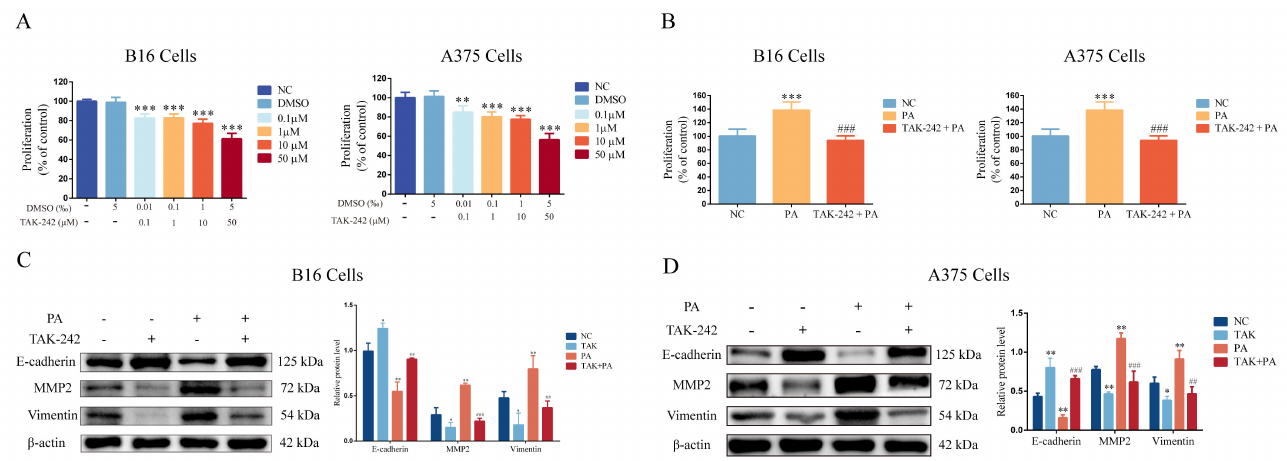
Figure 4. TAK-242 treatment inhibited the proliferation, and changed the expression, of EMT re- lated proteins induced by PA in the B16 and A375 cells. ( A ) The level of cell proliferation after B16 and A375 cells were incubated with TAK-242. ( B ) The level of cell proliferation after B16 and A375 cells were incubated with TAK-242 and/or PA for 24 h. ( C ) Protein levels and quantitative anal- ysis of E-cadherin, MMP2, and Vimentin in B16 cells incubated with TAK-242 and/or PA for 24 h. ( D ) Protein levels and quantitative analysis of E-cadherin, MMP2, and Vimentin in A375 cells incubated with TAK-242 and/or PA for 24h. In A375 and B16 cells, treatment with PA or TAK-242 (+) and no treatment with PA or TAK-242 (-). * p < 0.05, ** p < 0.01, or *** p < 0.001 compared with the control group. ## p < 0.01, or ### p < 0.001 compared with the PA group; the significance of the